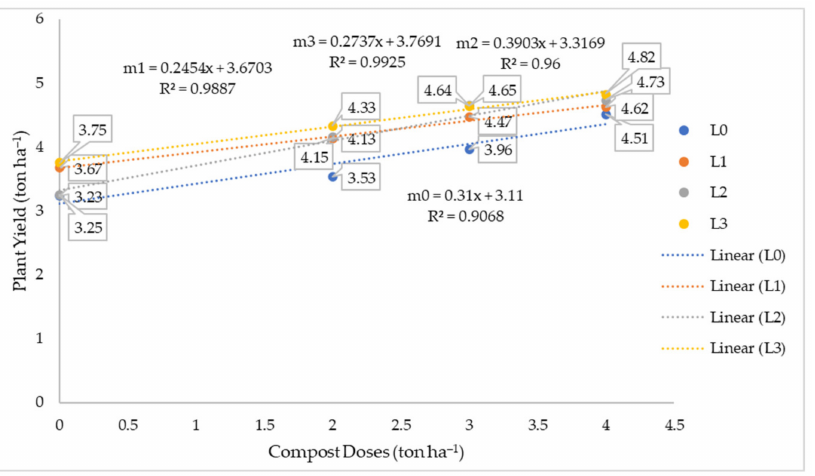
Figure 4. Polynomial–orthogonal interaction analysis of the rice yield character for the type of local liquid organic fertilizer (L) for the dose of